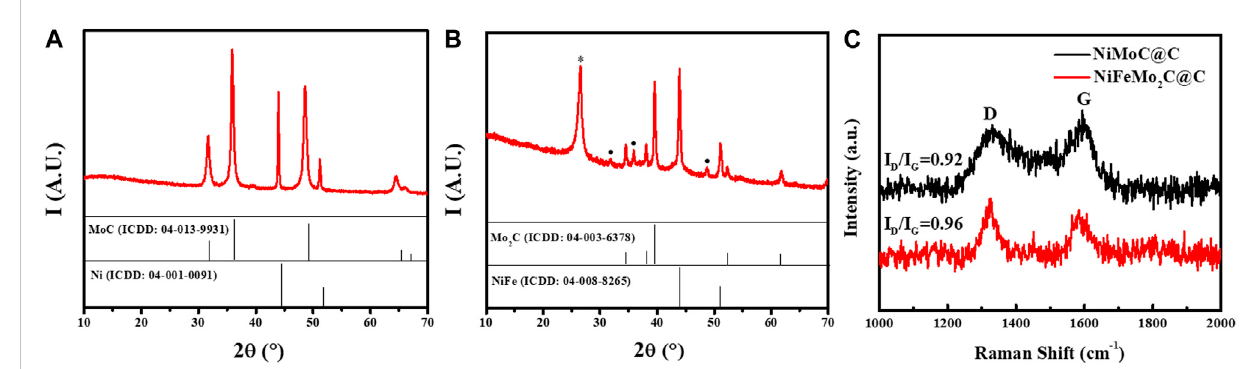
FIGURE 2 XRD patterns of as-prepared NiMo- (A) and NiFeMo- (B) based samples. (C) Raman spectra of the NiMoC@C and NiFeMo 2 C@C. The reference patterns ofMoC(ICDD: 04 – 013 – 9931),NiFe(ICDD: 04 – 008 – 8265), Mo 2 C (ICDD:04 – 003 – 6378),Ni(ICDD: 04 – 001 – 0091)are reportedas vertical full (cid:129) lines, for comparison. The peak marked with * and are attributed to carbon (ICDD: 04-15-2407), and MoC,